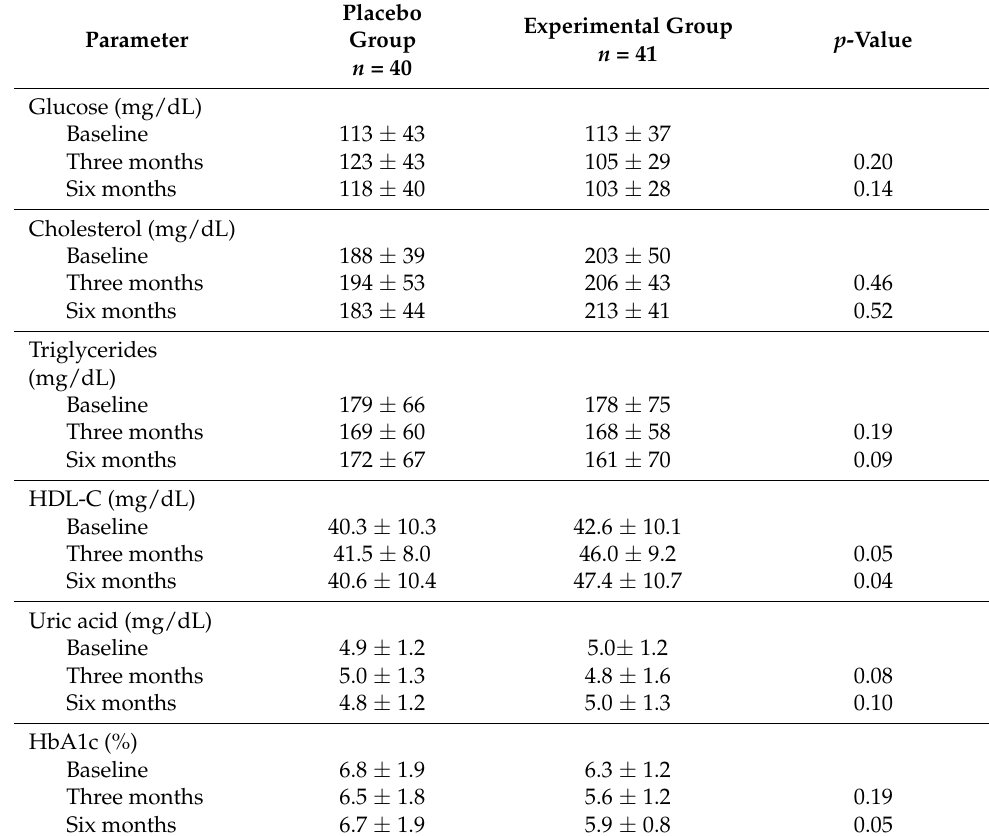
Table 2. Pre- and post-treatment biochemical parameters by study group.